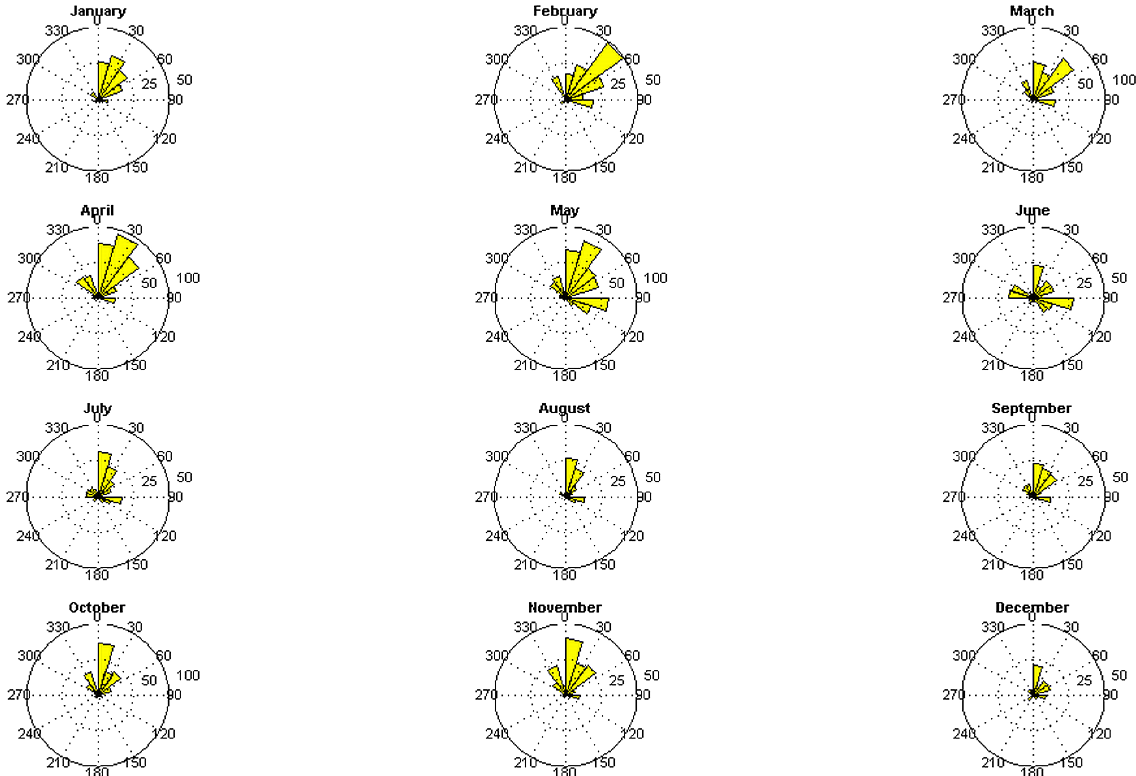
Figure 8. Monthly wind directions during dust events in the southern part of Iceland, 1949–2011. Weather stations that observed mainly wind directions of: 0–18 ◦ – Höfn, Eyrarbakki, Kirkjubæjarklaustur, Stórhöfði, Þingvellir; 18–36 ◦ – Höfn, Vatnsskarðshólar, Hjarðarland, Reykjavík, Keflavík; 36–54 ◦ – Hella, Vatnsskarðshólar, Vík; 54–72 ◦ – Hæll, Vatnsskarðshólar; 90–108 ◦ – Stórhöfði, Vatnsskarðshólar; 270– 306 ◦ – Vatnsskarðshólar; and 306–342 ◦ – Höfn. Dashed circles depict the number of dust observations reporting relevant wind